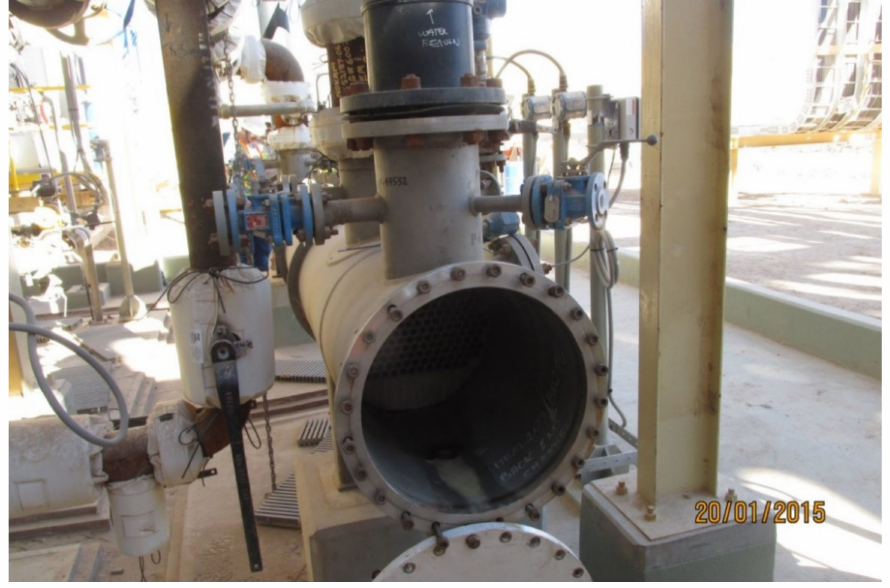
Figure 11. A small sulphuric acid cooler in Z100 superduplex. Photo courtesy of Steve